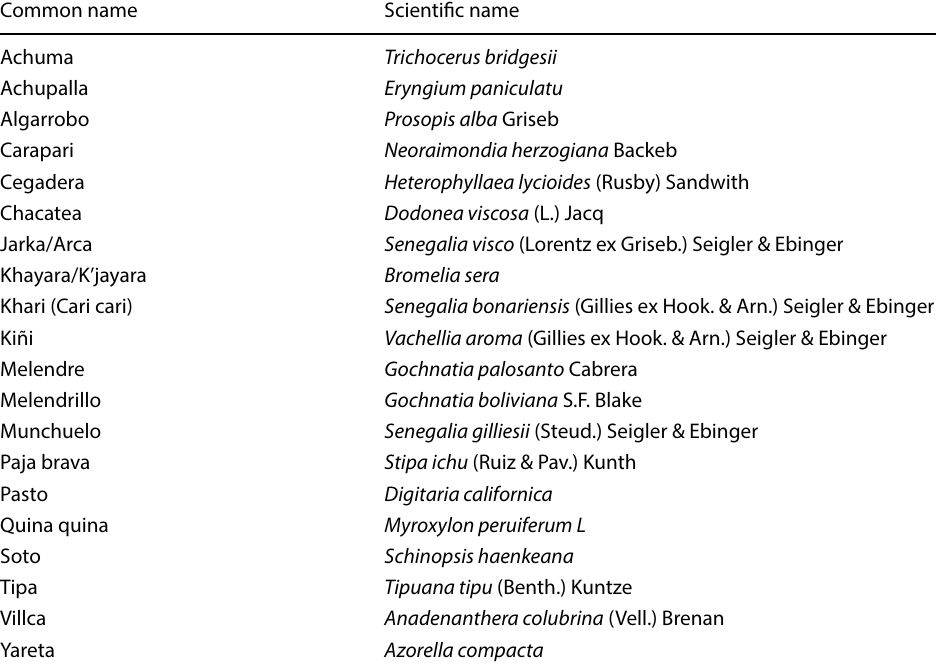
Table 1 List of native plant species consumed by cattle in Pasorapa,